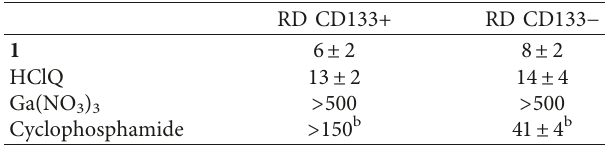
Table 3: IC a [ μ M] determined in CD133-positive and CD 50 values 133-negative Rhabdospheres as determined by Cell TiterGlo 3D after 72h incubation with indicated